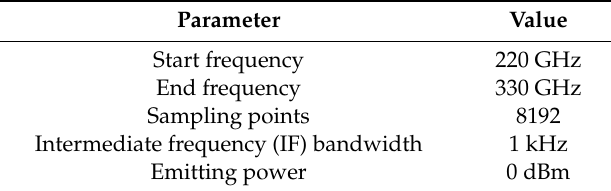
Table 1. Vector network analyzer (VNA) configuration parameters.